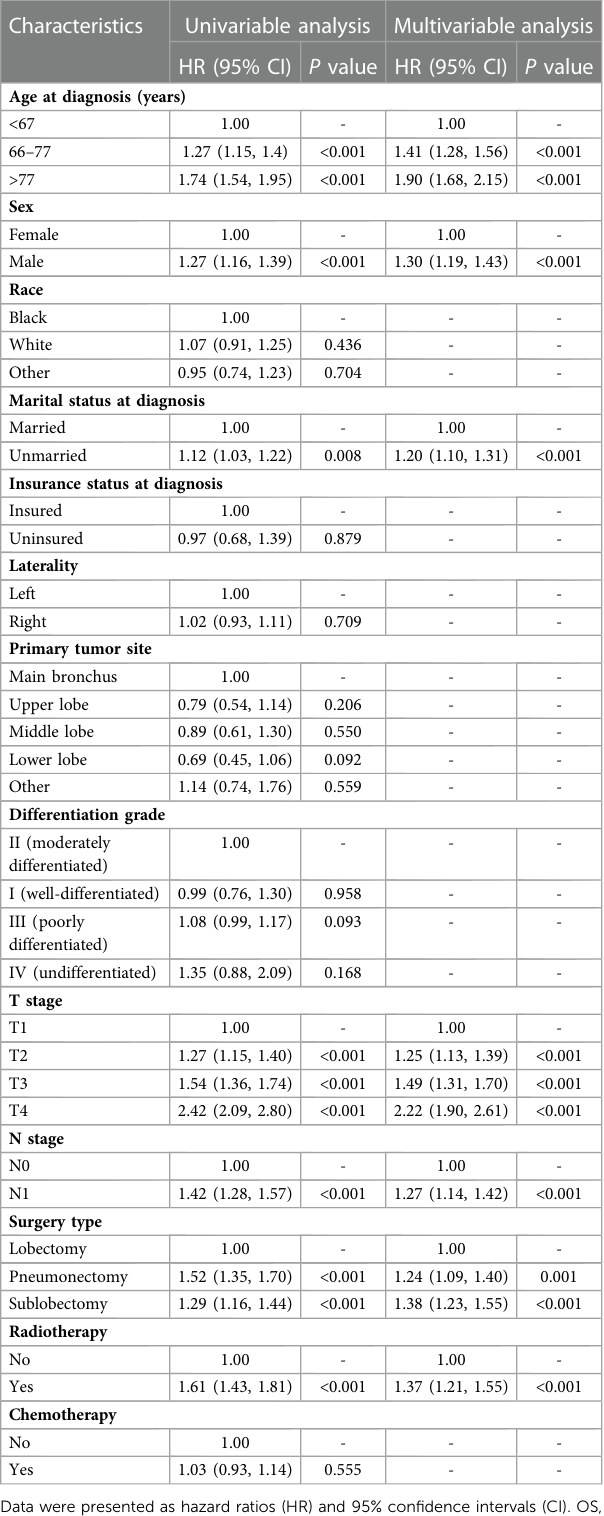
TABLE 2 Univariate and multivariate Cox regression analyses of OS predictors in LSCC patients.